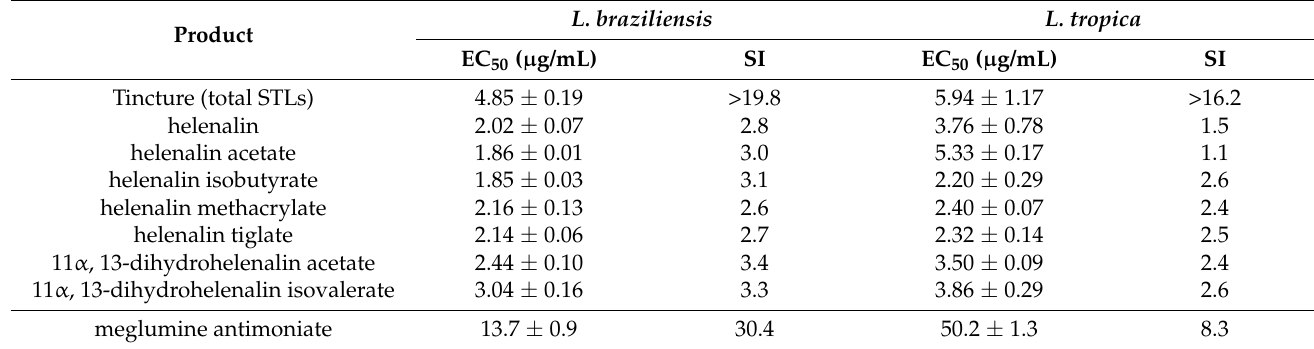
Table 2. Antileishmanial activity of Arnica tincture and isolated STLs. Data are expressed in µ g/mL and represent means ± SD ( n = 2 independent determinations with 3 replicates in each